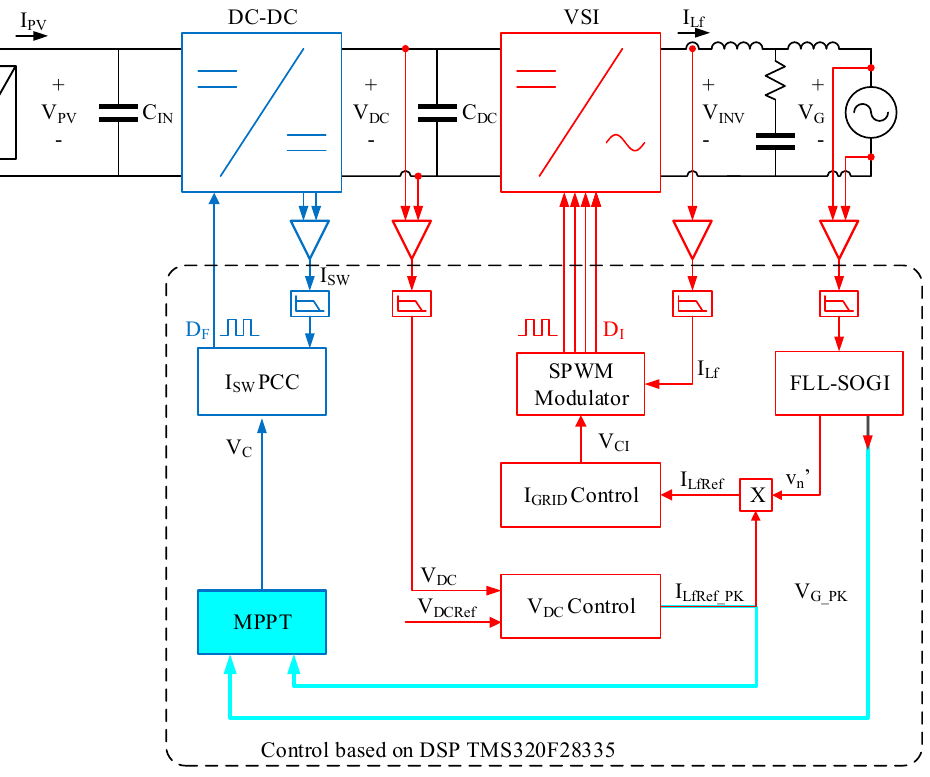
Figure 10. Proposed sensorless MPPT implementation.